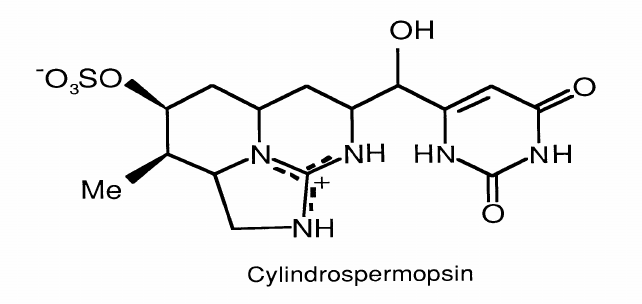
Figure 3: Molecular structure of the cyanobacterial alkaloid toxin cylindrospermopsin. The